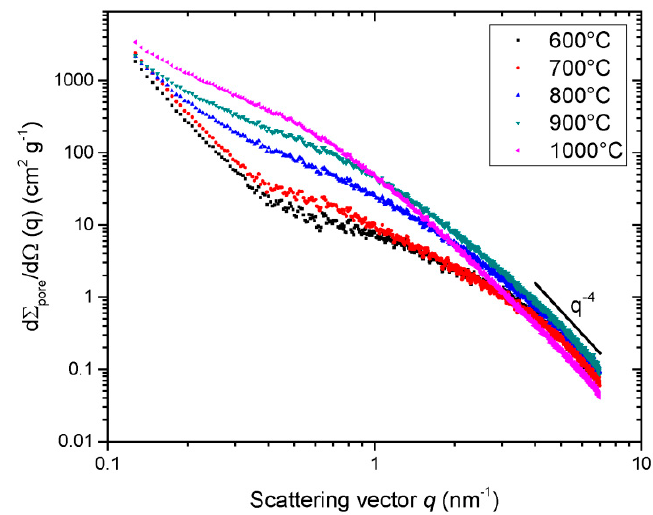
Figure 4. Analysis of CDCs by SAXS [75]. The fluctuation-induced contributions (see the discussion of Figures 2 and 3) have been subtracted from the measured scattering intensities. Hence, the scattering patterns shown in this graph are exclusively associated to the pores in a two-phase system. The color coding given in the graph refer to the different temperatures at which the materials have been synthesized [25,75]. For all CDCs, the final slope q − 4 was restored at the high scattering angles (see the discussion of Equation (4) above). Reproduced with permission from [75] copyright © 2019,